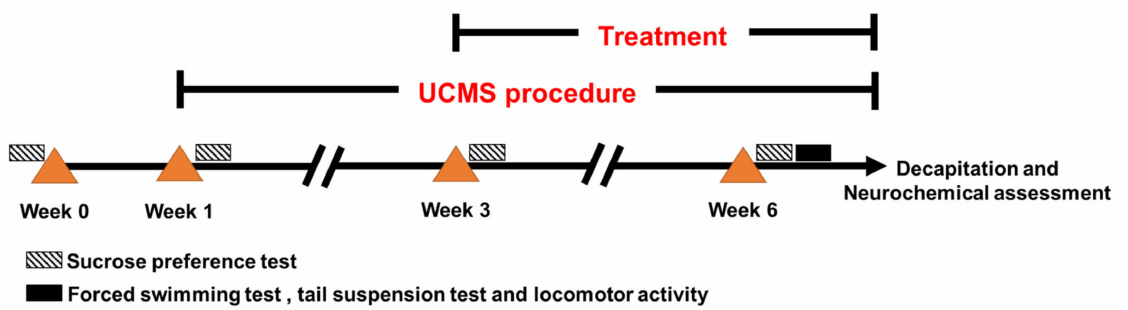
Figure 6. Schematic of experiment protocol. Mice were divided into five groups; a non-stress group administered 0.5% sodium carboxymethyl cellulose (SCMC) daily for 6 weeks (non-stress), and four UCMS groups. The UCMS groups were exposed to various stressors for 6 weeks. The UCMS mice were divided into four groups which were administered 0.5% SCMC (UCMS + vehicle), 20 mg/kg i.p. imipramine (UCMS + IMP20), 100 mg/kg p.o. KBD (UCMS + KBD100), or 500 mg/kg p.o. KBD (UCMS + KBD500) daily from week 3. The sucrose preference test was performed every week during the UCMS procedure. The forced swimming test (FST), tail suspension test (TST), and assessment of locomotor activity were conducted after week 6. After finishing the behavioral tests, all animals were decapitated, and their brains were collected for neurochemical